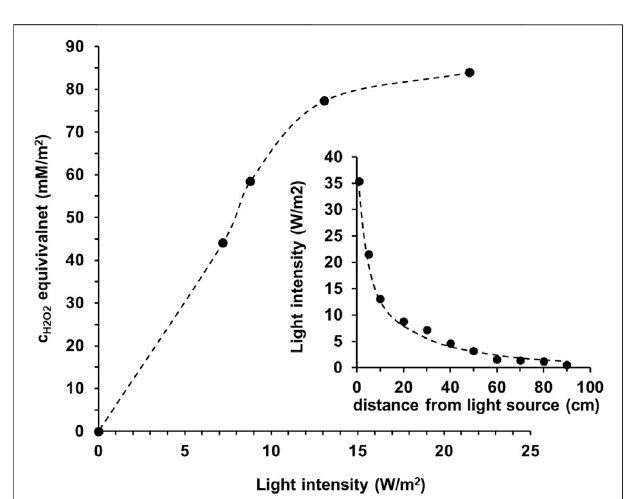
FIGURE3| TheeffectoflightintensityonthesurfaceROSconcentration produced under irradiance of the photoreactive layer. The inserted fi gure showsthedistancedependenceoflightintensity(herethedashedlineisguide to